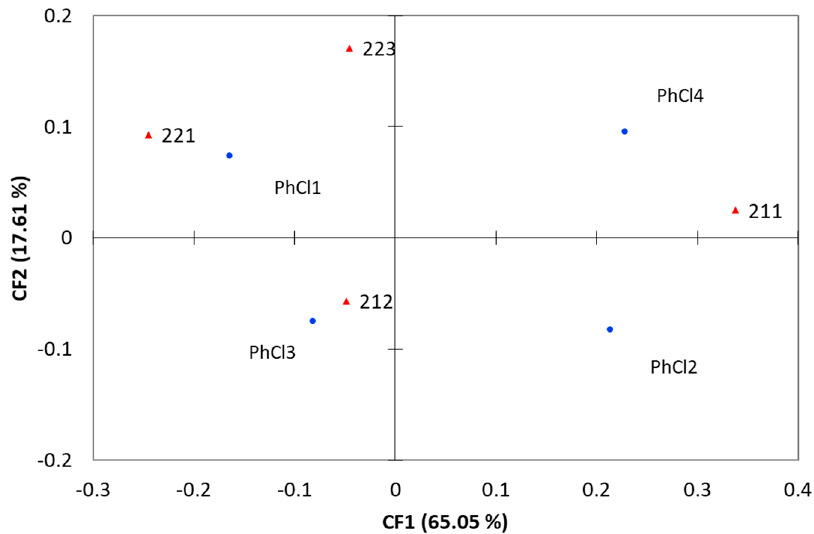
Figure 8. CFA biplot between the four pheno-clusters (PhCl) (blue dots) and the agricultural land use types (red triangles).